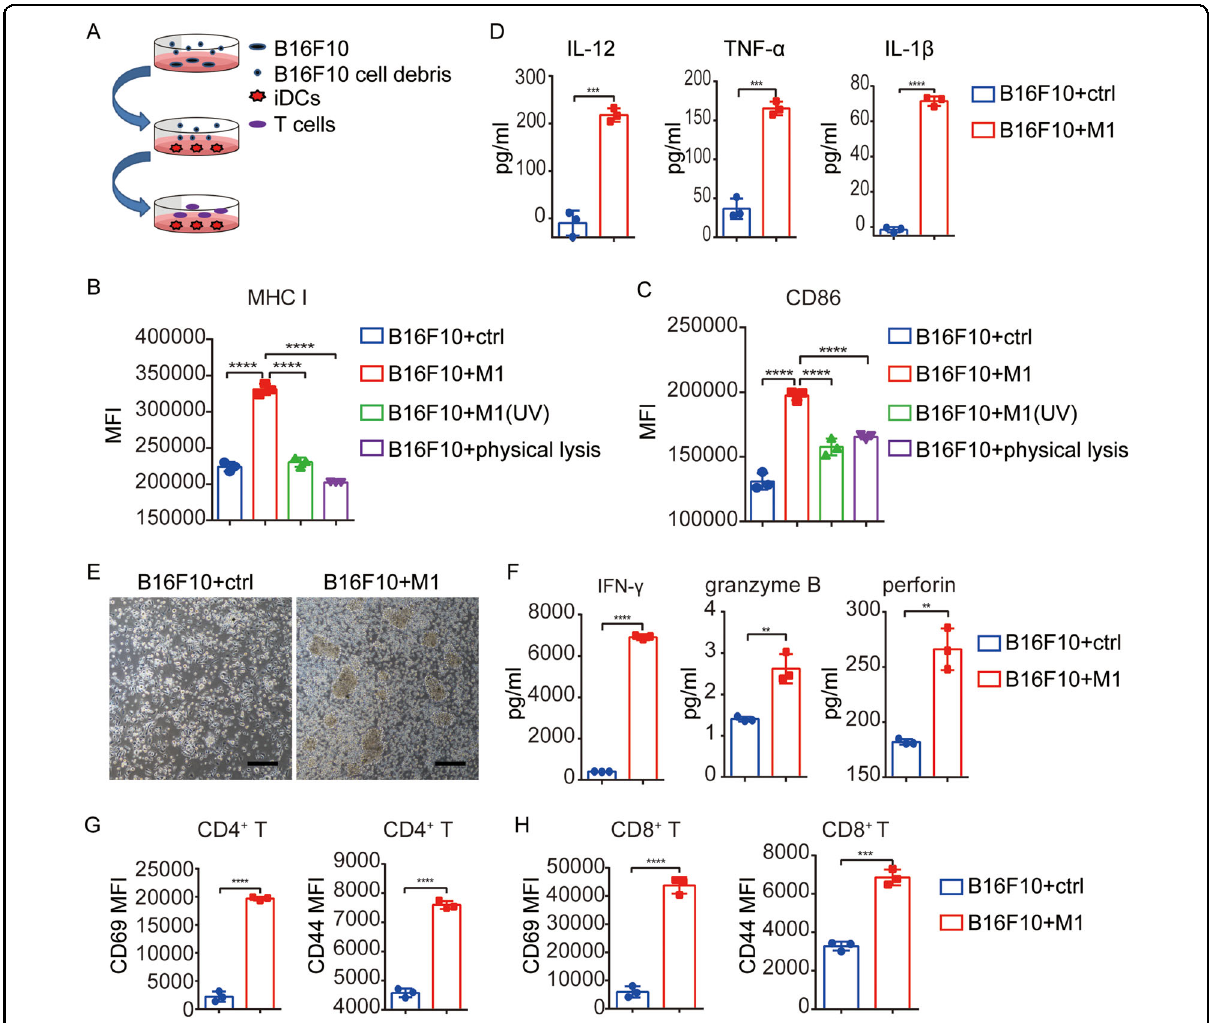
Fig. 3 Tumor cells lysed by M1 mature iDCs and enable the iDCs to prime de novo T-cell responses ex vivo. A Diagrammatic sketch of the coculture experiment performed ex vivo. B16F10 cells were treated with ctrl, M1, UV-inactivated M1, or physical lysis on day 0, and then the supernatant of each group was collected and fed to immature DCs (iDCs) on day 2. One batch of DCs was used to detect maturation markers by fl ow cytometry and secreted cytokines by ELISA on day 4. The other batch of DCs was cocultured with naive T cells on day 4, and T-cell activation was evaluated on day 8. B , C MHC I ( B ) and CD86 ( C ) expression on DCs fed the indicated supernatants was detected by fl ow cytometry on day 4. n = 3. P values were determined by one-way ANOVA with Dunnett ’ s tests for multiple comparisons. D IL-12, TNF- α , and IL-1 β levels in the culture medium of DCs fed with the indicated supernatants were determined by ELISA on day 4. n = 3. The P value was determined by a two-tailed Student ’ s t test. E Phase-contrast images of proliferating T-cell clones on day 8 are shown. The images are representative of three independent experiments. Scale bars, 50 μ m. F IFN- γ , granzyme B, and perforin concentrations were determined by ELISA in the DC plus T-cell coculture system on day 8. n = 3. The P value was determined by a two-tailed Student ’ s t test. G-H, CD69, and CD44 expression on CD4 + T cells ( G ) and CD8 + T cells ( H ) was evaluated on T cells in the DC plus T-cell coculture system on day 8. n = 3. The P value was determined by a two-tailed Student ’ s t test. Data are shown as the mean ± SD. ** P < 0.01; *** P < 0.001; **** P < 0.0001. See also in Supplementary Figs. S3 and